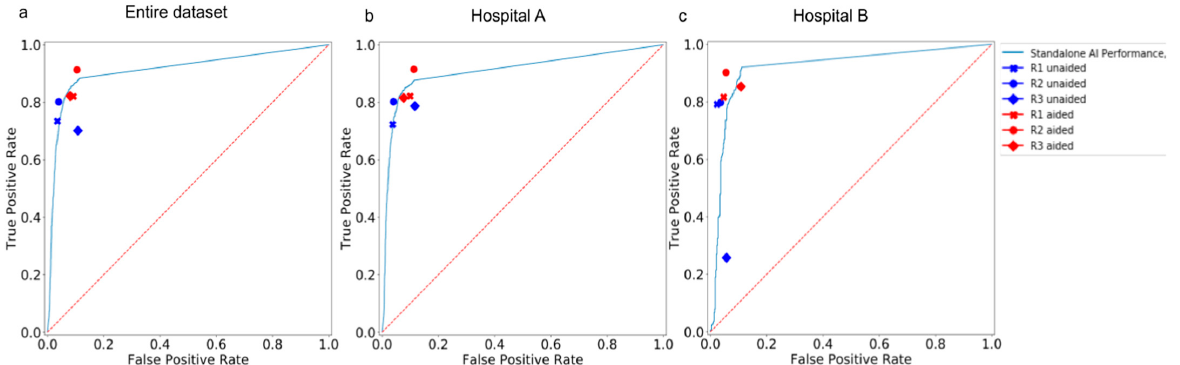
Figure 5. AUROC curves depicting the performance of standalone AI, unaided readers, and aided readers on ( a ) the entire hospital dataset, ( b ) the dataset from Hospital A, and ( c ) the dataset from Hospital B.